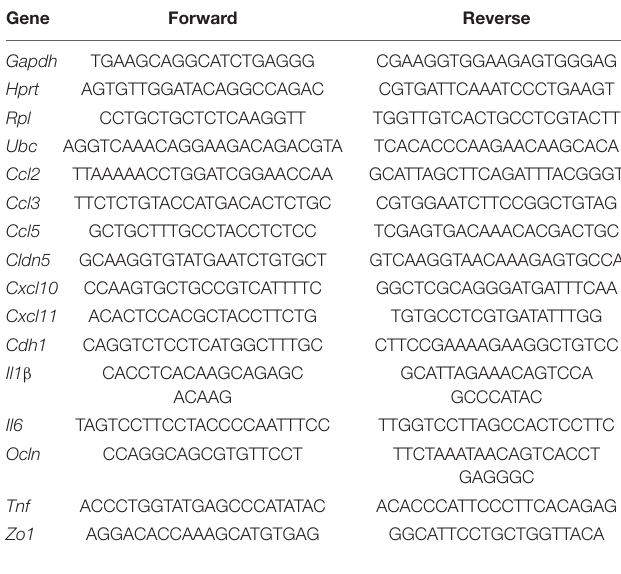
TABLE 1 | Overview of used RT-qPCR primer